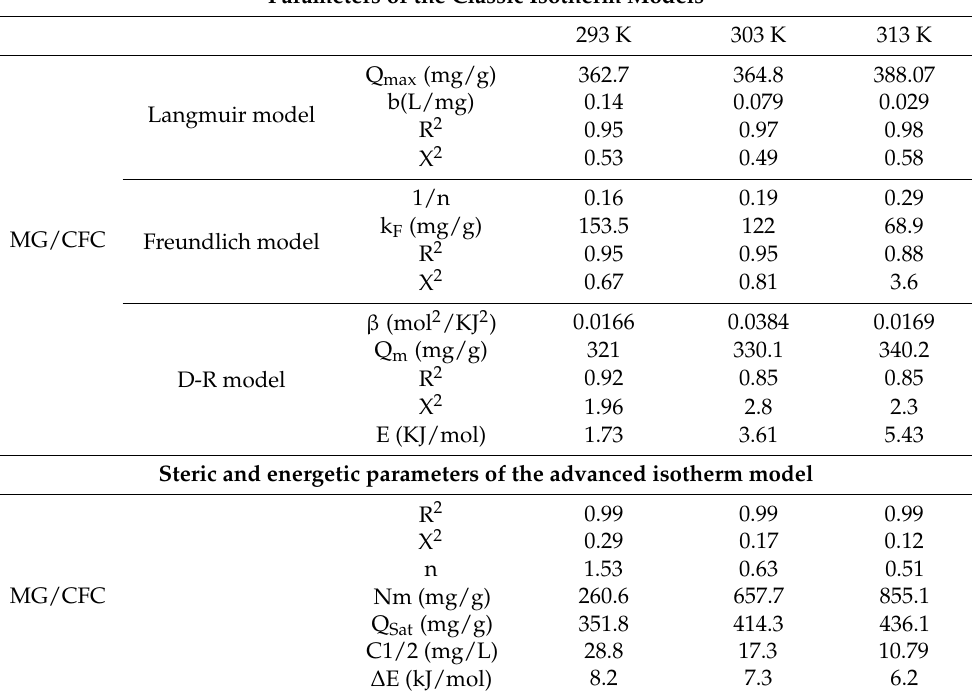
Table 1. The estimated mathematical parameters of the studied classic and advanced equilibrium